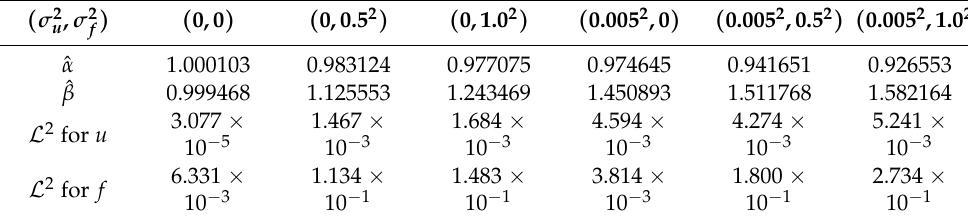
= 20, ( α , β ) is fixed to be (1,1). f